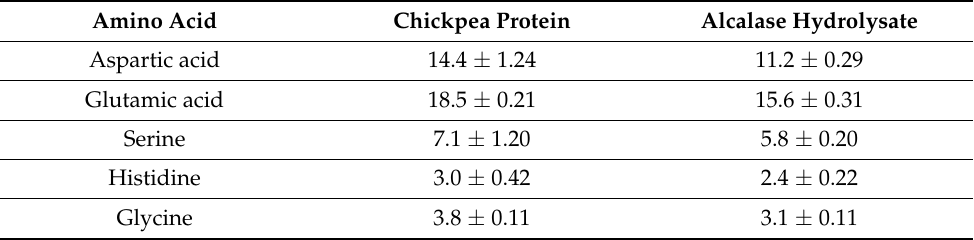
Table 3. Amino acid composition (grams per 100 g of protein) of different chickpea purified pep- tide